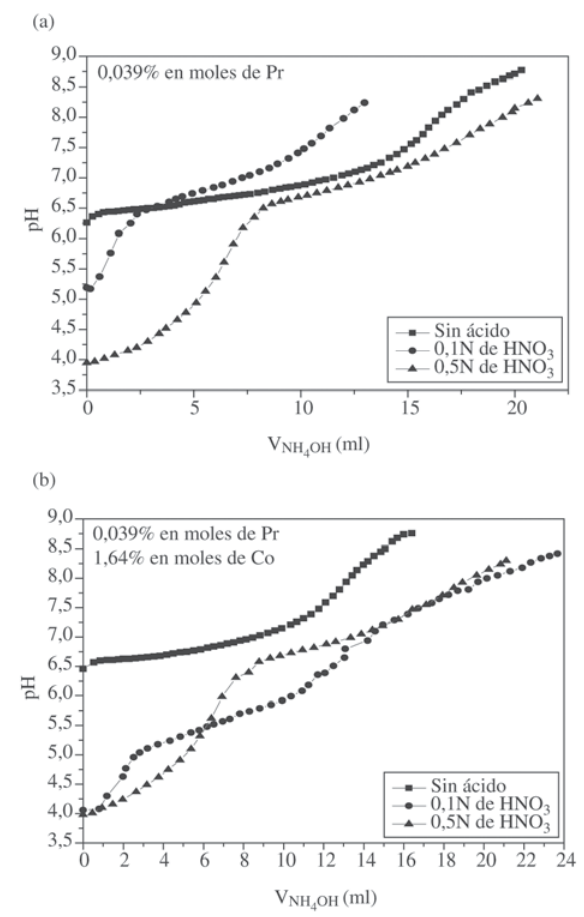
Figura 3. Efecto del contenido de HNO valoración potenciométrica correspondientes a (a) un sistema acuoso de cinc - praseodimio y (b) un sistema acuoso cinc - praseodimio -